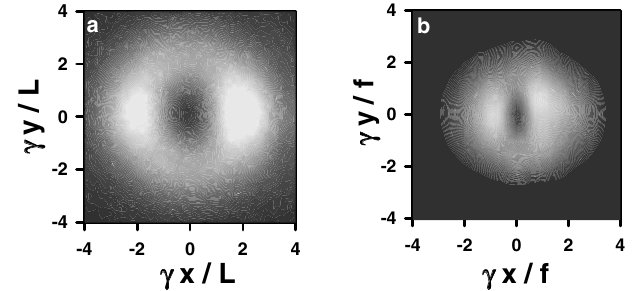
FIG. 15. OTR spatial distribution measured without (a) and with (b) the lens ( f (cid:5) 0 : 2 m ). Optical filter and polarizer were removed during these measurements.